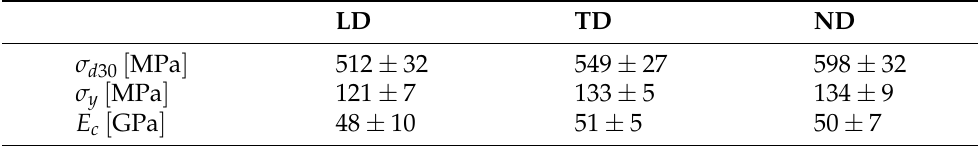
Figure 7. Stress–strain response of WAAM-fabricated AA2319 in the longitudinal, transverse, and normal directions. Table 4. Mechanical properties of WAAM-fabricated AA2319 in LD, ND, and TD directions obtained by compression test results, shown in Figure 7. σ d 30 , σ y and E c are strength at compressive strain of 30%, compressive yield strength, and compressive Young’s modulus,